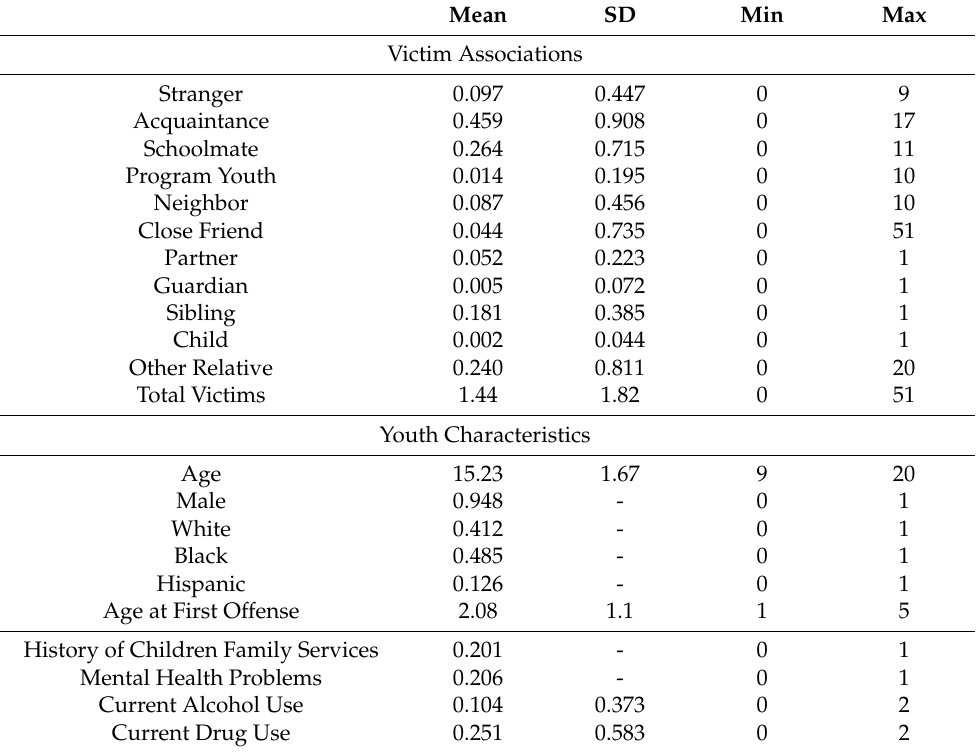
Table 1. Descriptive statistics for the analysis of the victims of juvenile sex